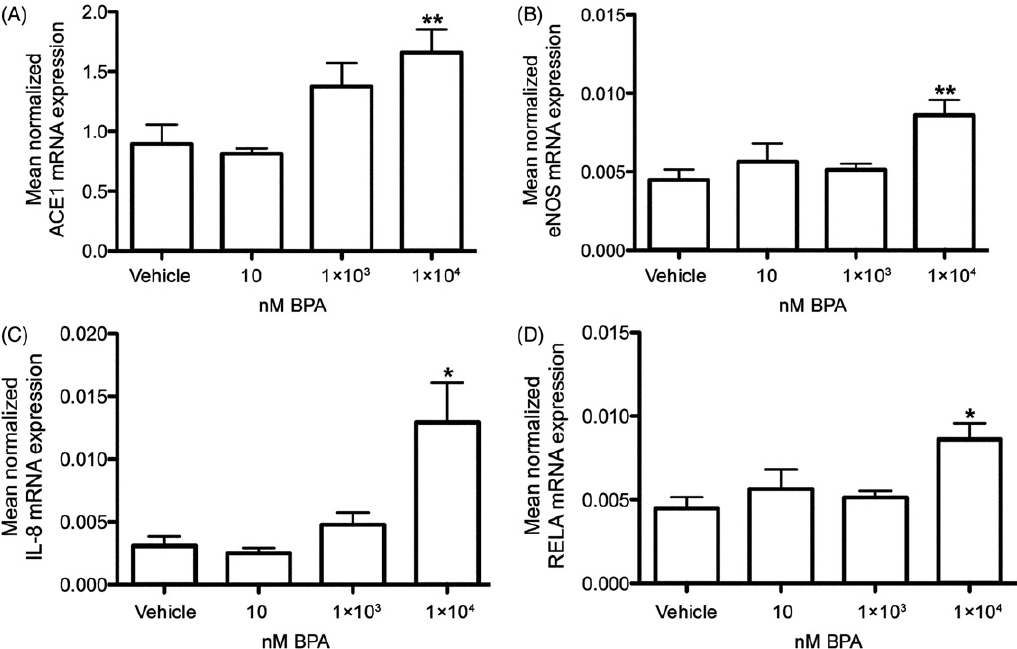
Figure 2. In vitro effects of BPA exposure on ACE1 , eNOS , IL-8 , and NF jb mRNA expressions in primary human cardiomyocytes. Treatment of human cardiomyocytes with 1 (cid:1) 10 4 nM BPA for 6hours increased the mRNA expression of ACE1 (A), eNOS (B), IL-8 (C), and NF jb (RELA) (D), compared to vehicle controls. Each bar represents mean normalized mRNA expression±SEM of three cell cultures, each analyzed in three replicates.